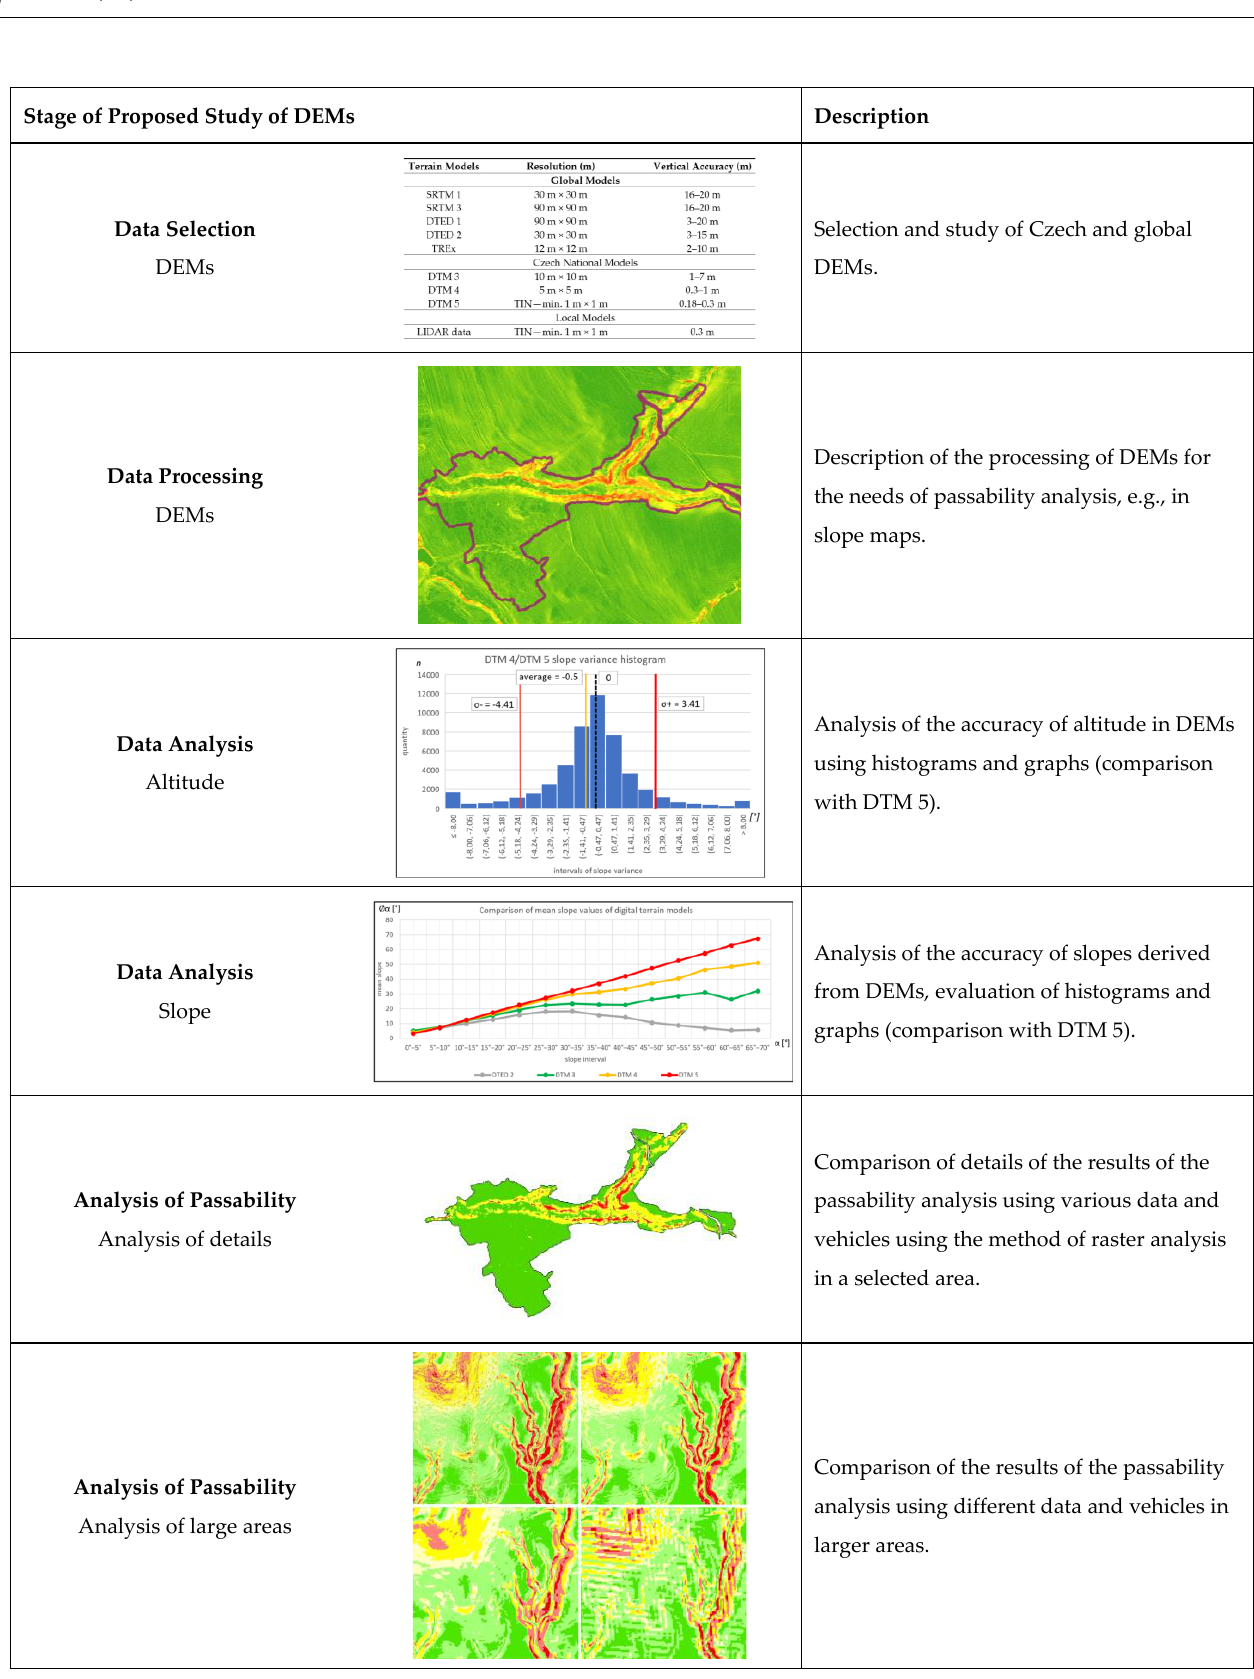
Figure 1. Scheme of the procedures within the study of DEMs and results of the passability analysis.